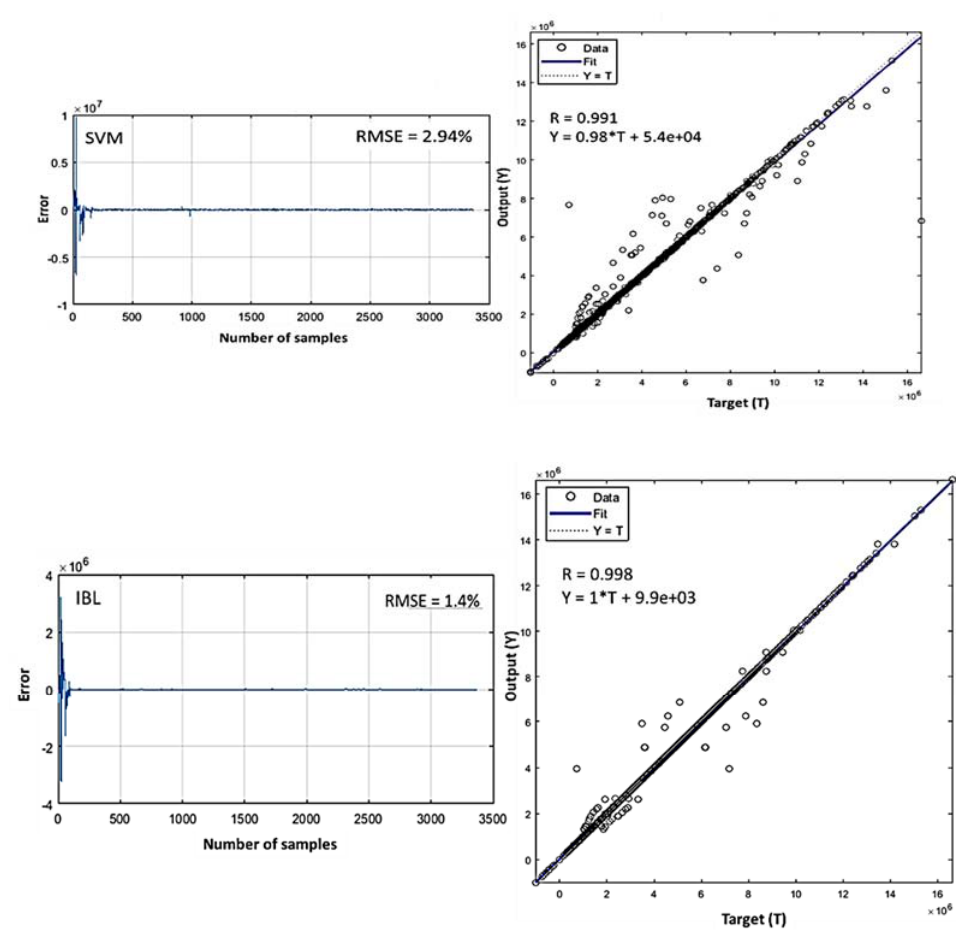
Figure 2. Model performance over the training phase.